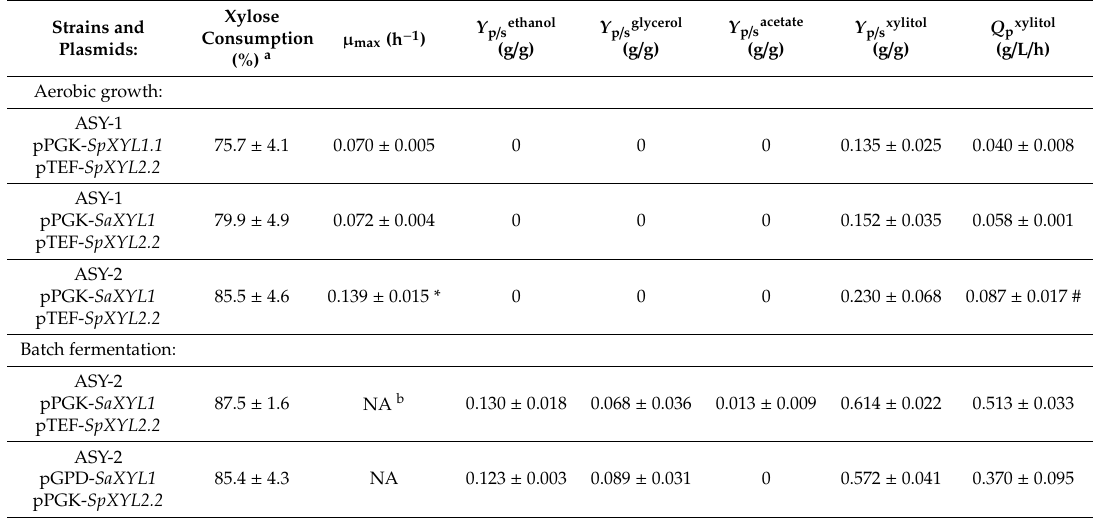
Table 6. Xylose consumption and product formation by recombinant S. cerevisiae